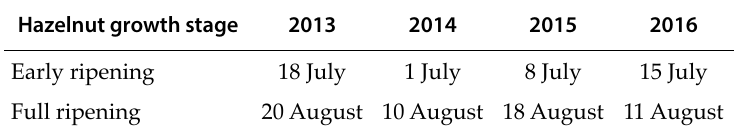
Table 2. Date of hazelnut sampling managed in Chitatskari, Caucasus region, during the 4 year study (2013 to 2016). Hazelnut growth